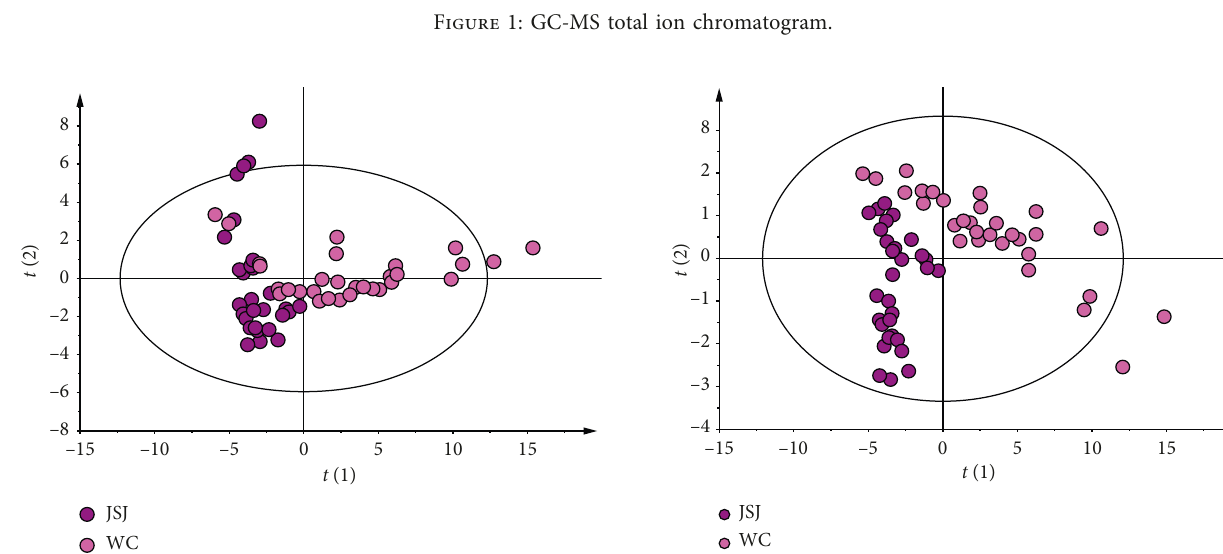
Figure 1: GC-MS total ion chromatogram.